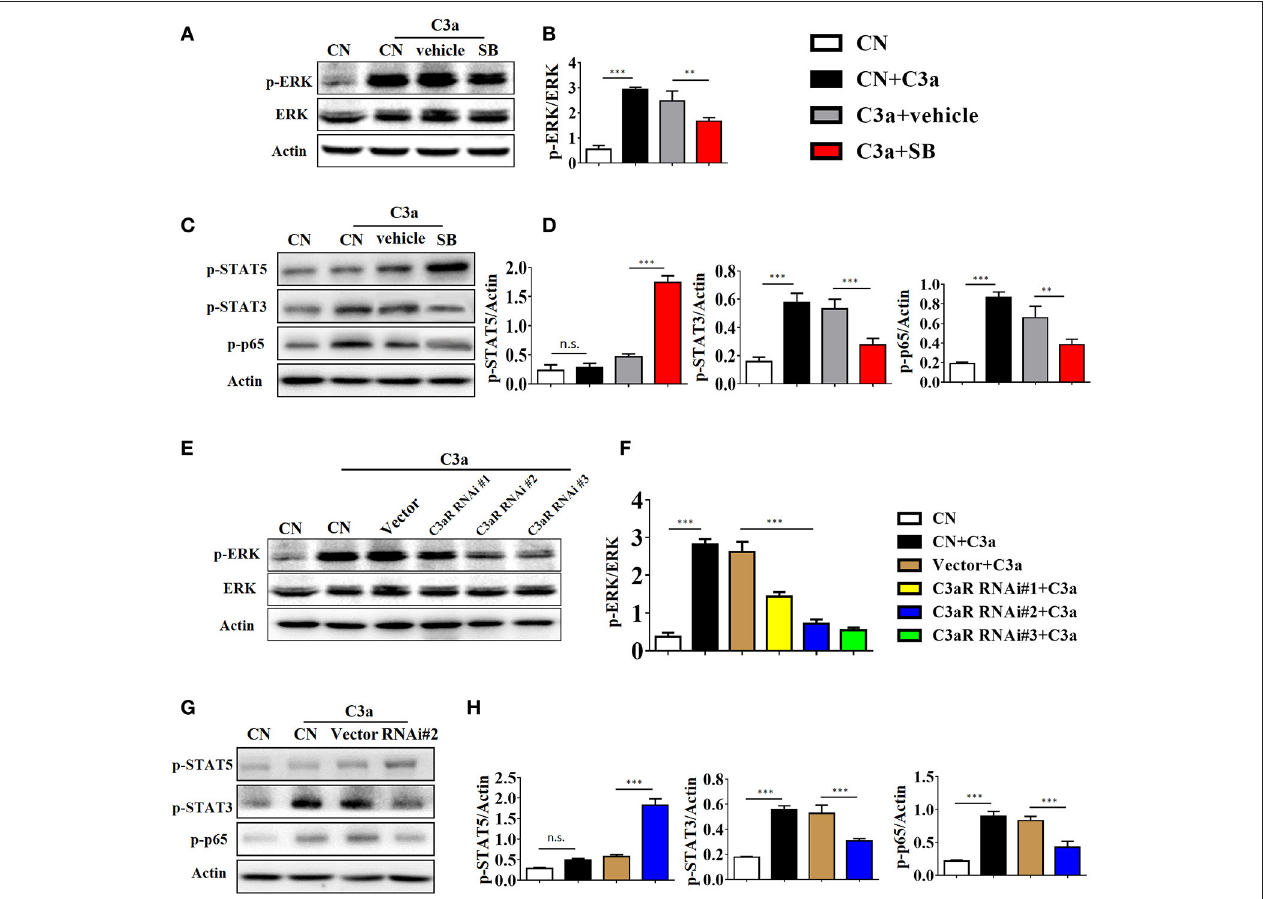
FIGURE 9 | C3a/C3aR signaling promotes the IL-17A production in T cells in vitro . (A,C) Splenocytes stimulated with C3a (20nM) for 30min in the presence or absence of SB290157. Extracellular signal-regulated kinase-1/2 (ERK1/2), signal transducers and activators of transcription-3/5 (STAT3/5), and nuclear factor (NF)-kB p65 subunit phosphorylation were detected by Western blotting. (B,D) The histogram shows the relative intensity for each marker normalized to Actin. (E,G) T cells were knocked down endogenous C3aR by using siRNAs, and stimulated with C3a (20nM) for 30min, p-ERK, p-STAT3, p-STAT5, and p-p65 were detected by Western blotting. (F,H) The histogram shows the relative intensity for each marker normalized to Actin. The error bars represent the SEM. ** P < 0.01; *** P <